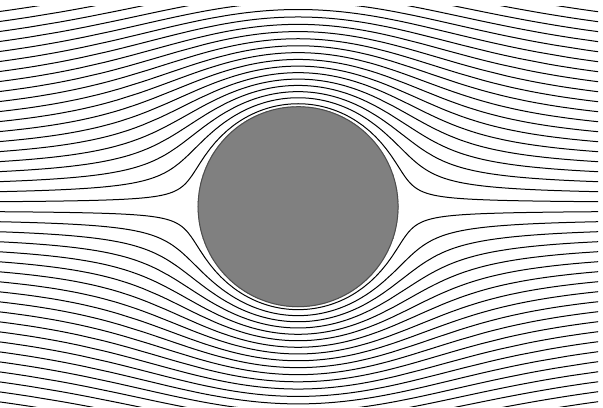
Figure 2. Streamlines in the symmetry plane for a uniform flow past a rigid sphere. The radius of the rigid sphere is a =